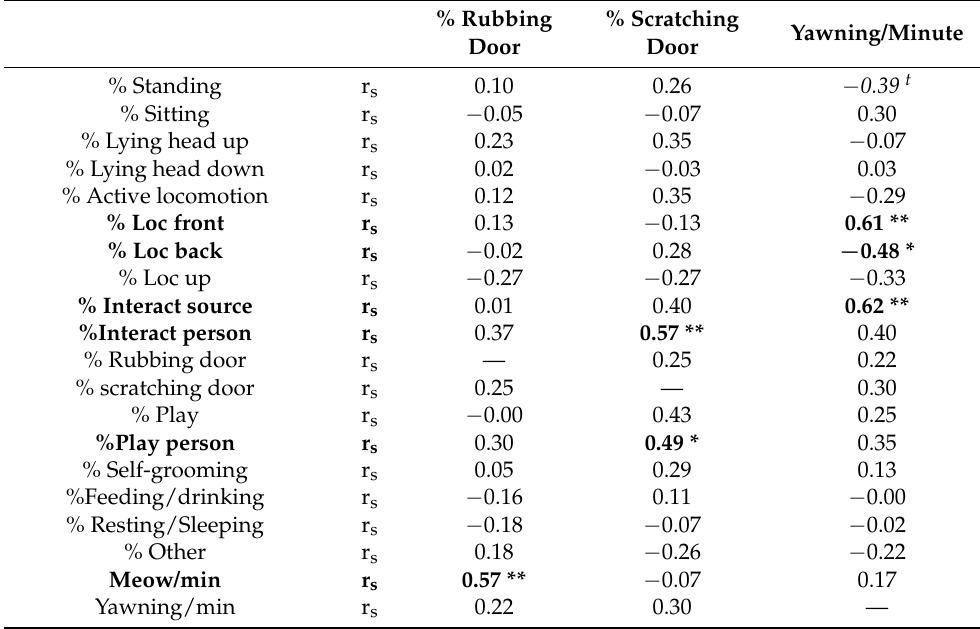
Table 7. Spearman rank correlations between “% Watch source”, “% Rubbing door”, “% Scratch- ing door” and “% Yawning” and the other behaviours recorded in cats during the P+ condition. Significant correlations are depicted in bold, tendencies in italics. % Rubbing %